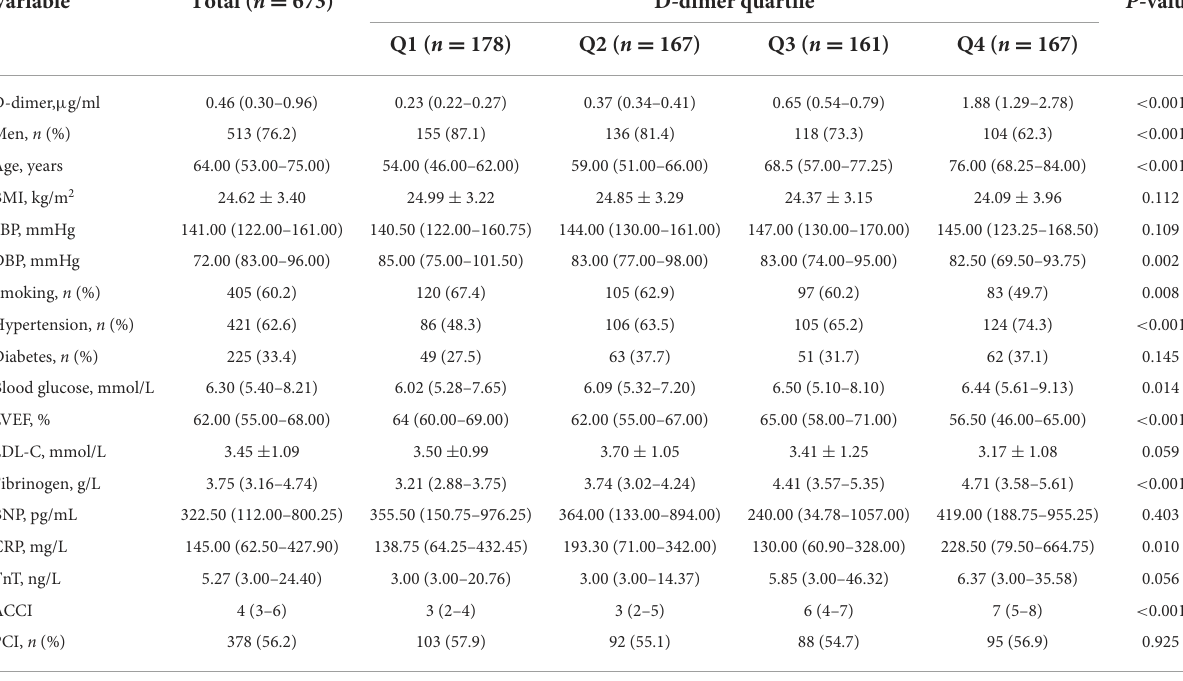
TABLE 1 Baseline characteristics of patients with non-ST-segment elevation myocardial infarction (NSTEMI). Variable